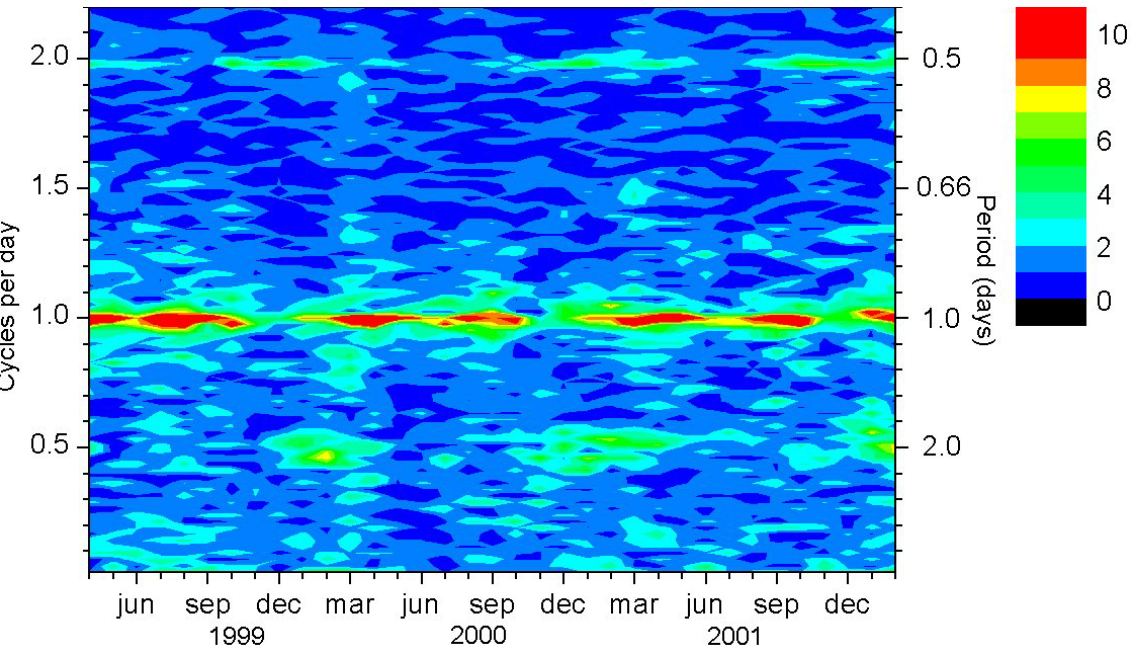
Fig. 13. Spectrum of the meridional wind measured by meteor radar at Cachoeira Paulista (23 ◦ S) between April 1999 and February 2002 (after Batista et al.,